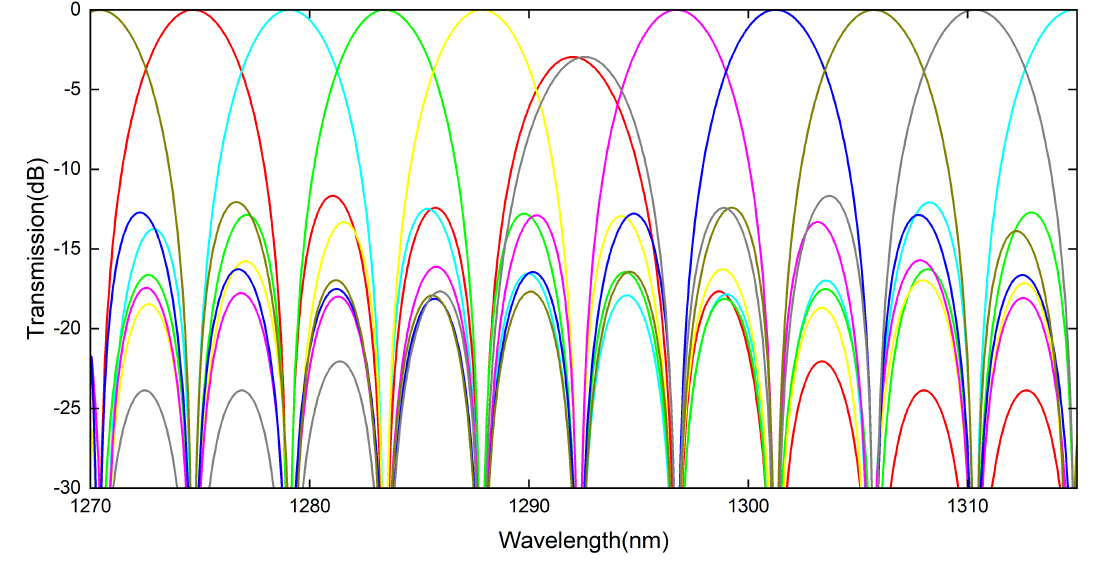
Figure 3. Measured transmission of the 8-channel